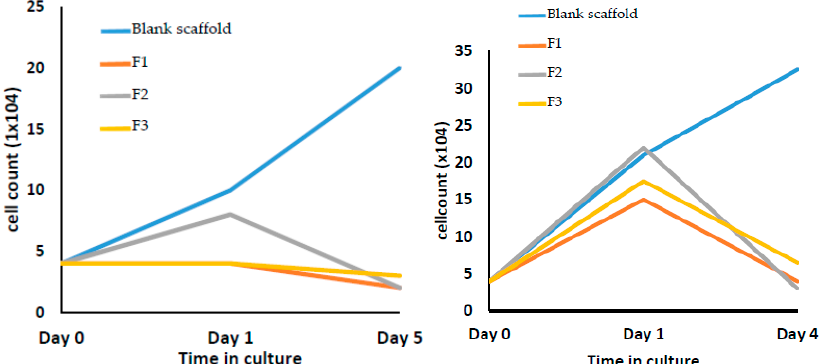
Figure 11. In vitro cell culture assessment of CPC blank scaffold and uncoated scaffold: F1 (coated with 5-FU), F2 (coated with 5-FU and Soluplus), F3 (coated with 5-FU, Soluplus and PEG 6000), with GFP labelled Hek293T ( left ) and HeLa ( right ) cells.